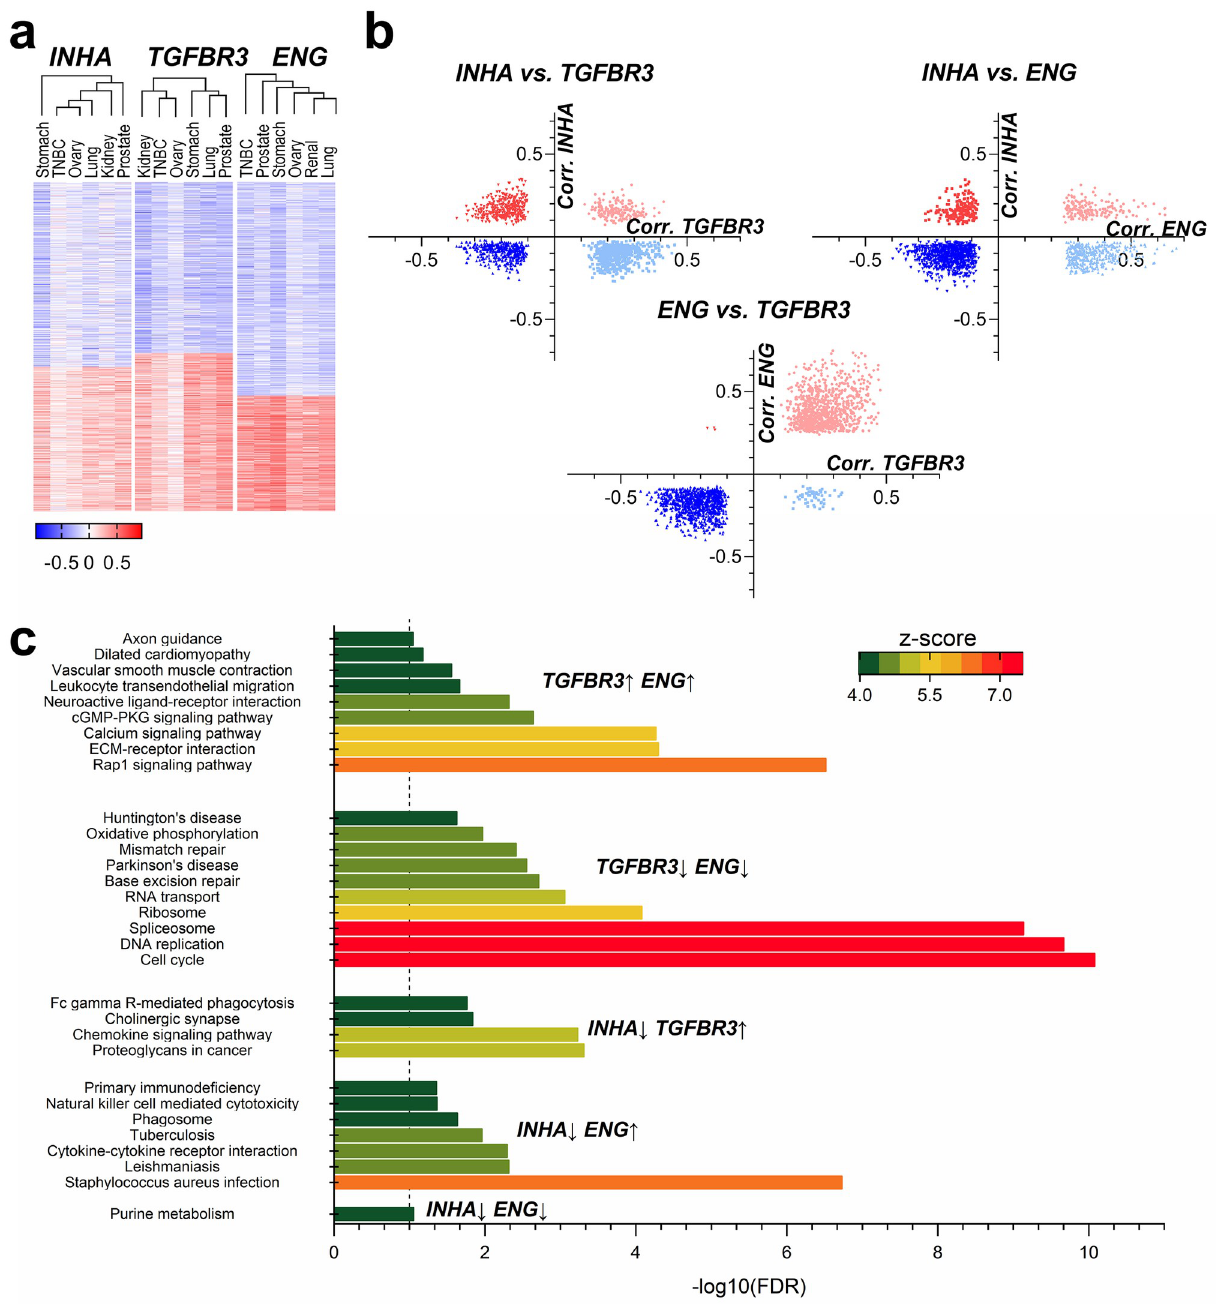
Fig 6. Functional analysis of gene signatures between INHA and TGFBR3 and INHA and ENG . (a) Supervised clustering of correlations of RNA-seq data between INHA , TGFBR3 , and ENG was performed to obtain sets of positive and negatively correlated genes for each set. (b) Common genes that were found in each group of correlated genes (e.g., negative correlation to INHA vs . positive to TGFBR3 and all combinations) is presented. (c) KEGG pathway analysis for groups of genes correlated with the indicated combination. Unique pathways with an FDR below 0.05 were identified for the comparisons and are